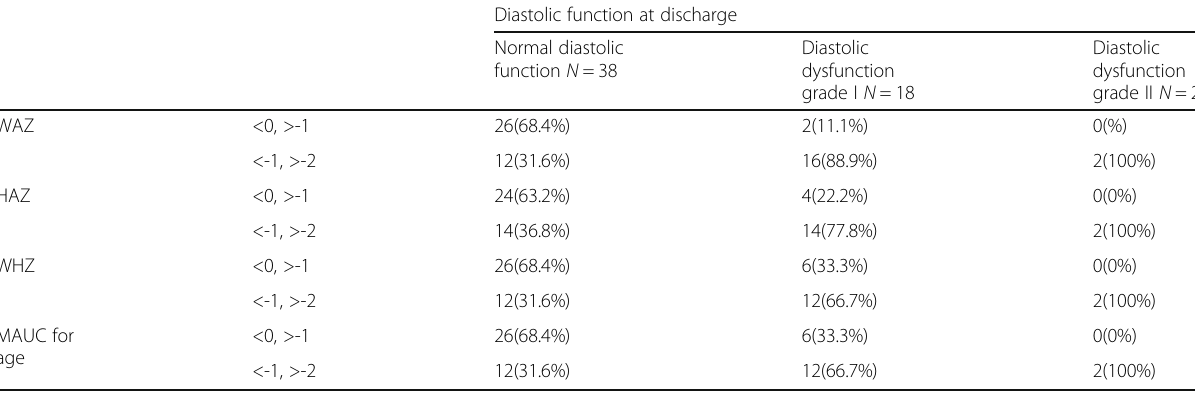
Table 5 Description of diastolic dysfunction grades in relation to anthropometric measurements in children with SAM after nutritional